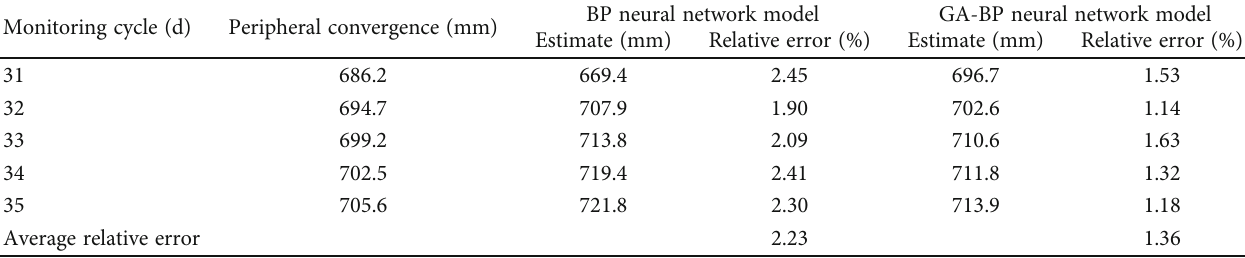
Table 3: Medium term forecast